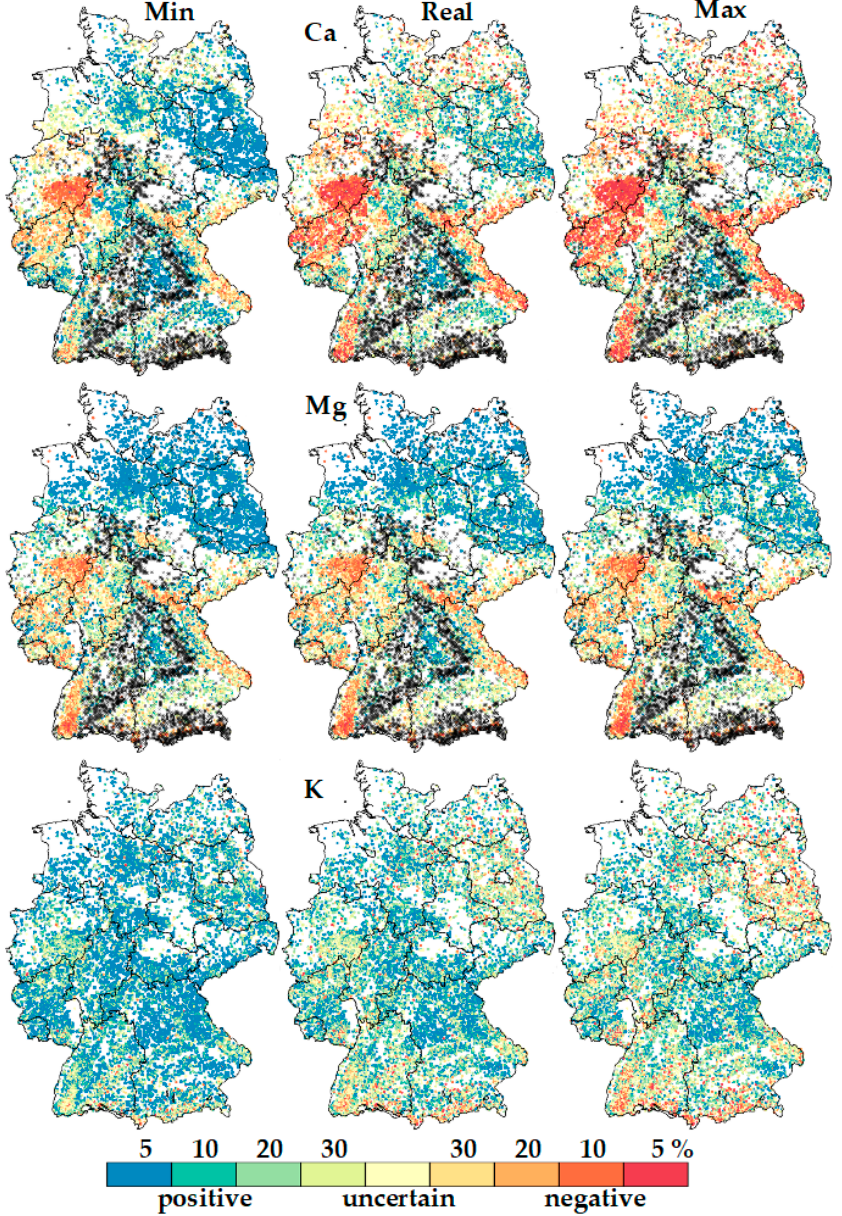
Figure 5. Effects of different intensities of biomass use on the nutrient balance of calcium (Ca), magnesium (Mg) and potassium (K) at the NFI tracts (scenario MIN: left column; scenario REAL: centre column; scenario MAX: right column). Balance deficits are shown in red, positive balances in blue. The colour intensity indicates the probability of error.